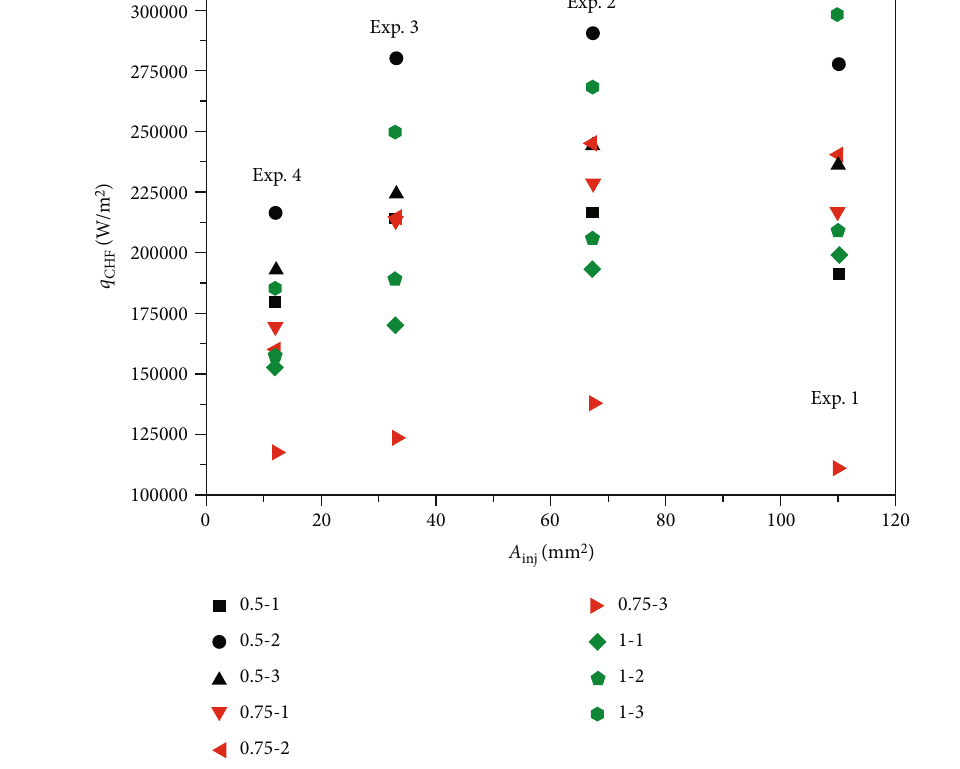
CHF versus A inj .